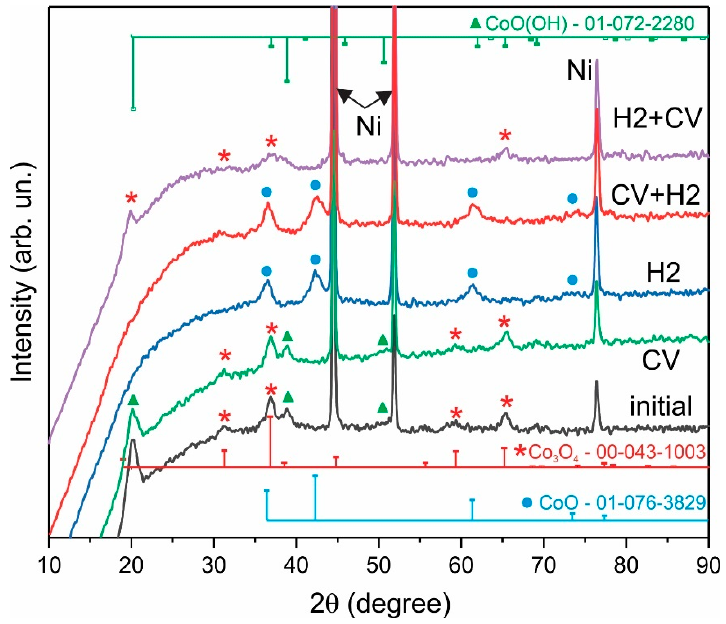
Figure 8. XRD patterns of the Co 3 O 4 NPs–NF electrode after annealing in air at 200 °C (initial), in situ oxidation (CV), H2-treatment (H2), in situ oxidation followed by H2-treatment (CV + H2), and H2-treatment followed by in situ oxidation (H2 + CV).